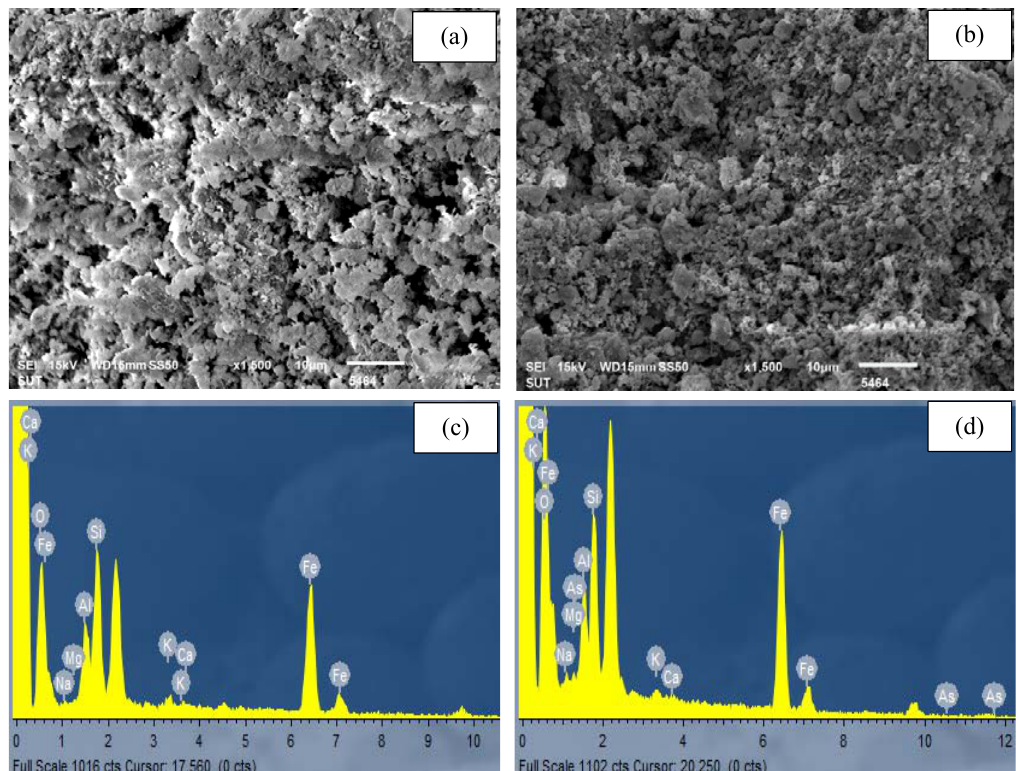
Fig. 2: SEM images of pre-adsorption of mesoporous pellet adsorbent (a), post-adsorption of mesoporous pellet adsorbent (b), and EDS analysis of the adsorbent before and after adsorption (c) and (d), respectively